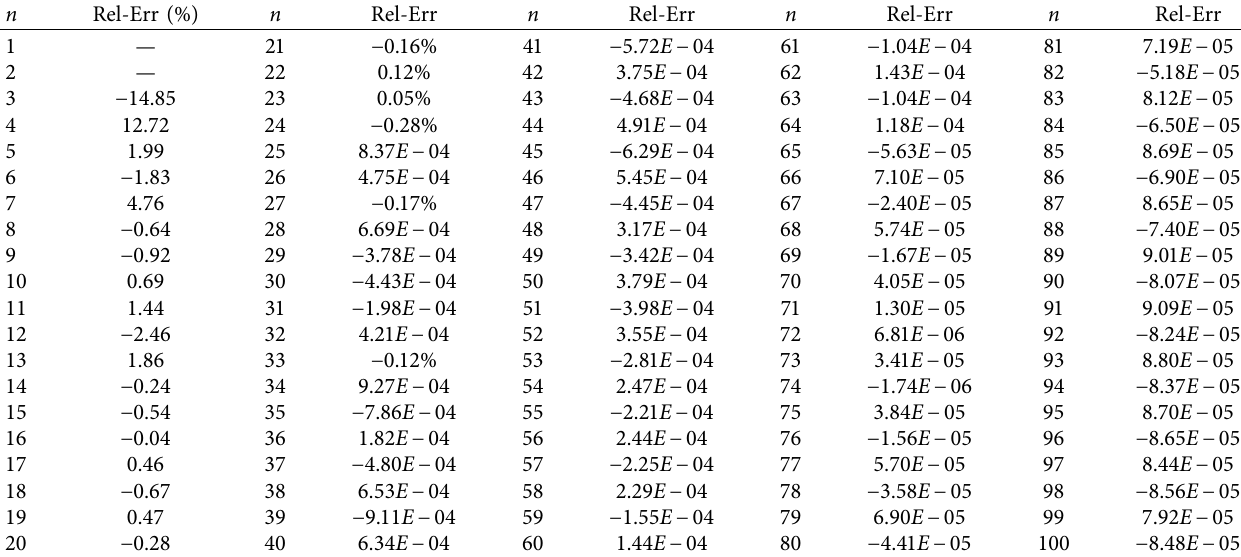
( n ) to h ( n ) when n ≤ 100. g0